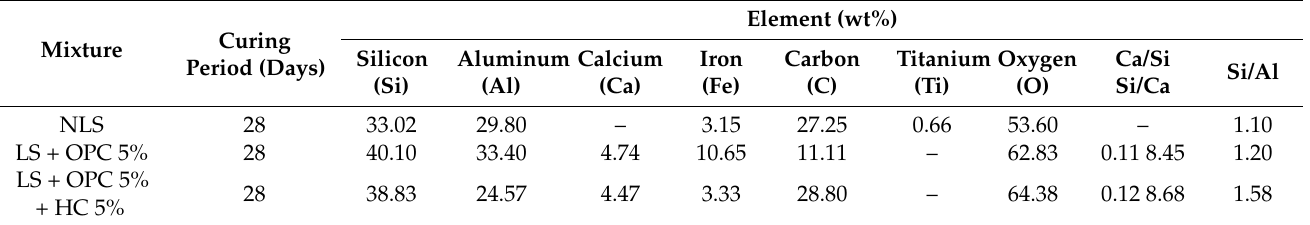
Table 4. EDX analysis for untreated and treated lateritic soil after the compressive strength test at a curing period of 28